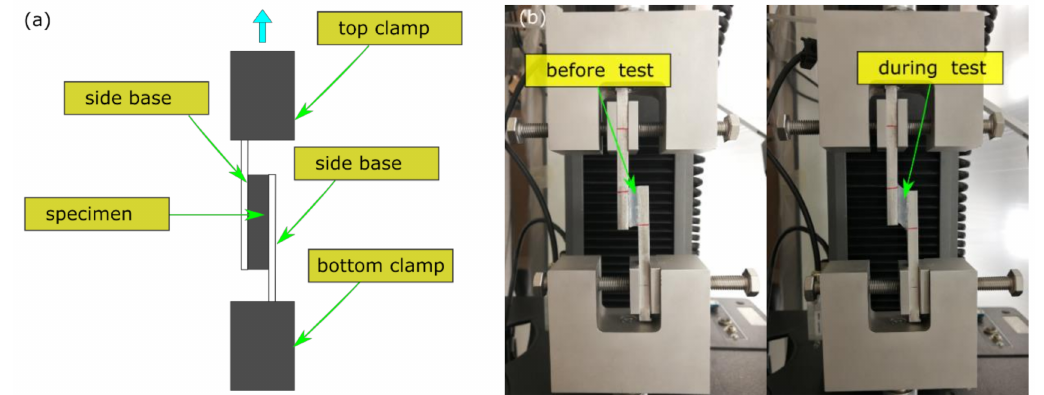
Figure 3. Simple shear test: ( a ) schematic testing setup; ( b ) shapes of specimen before and during test.